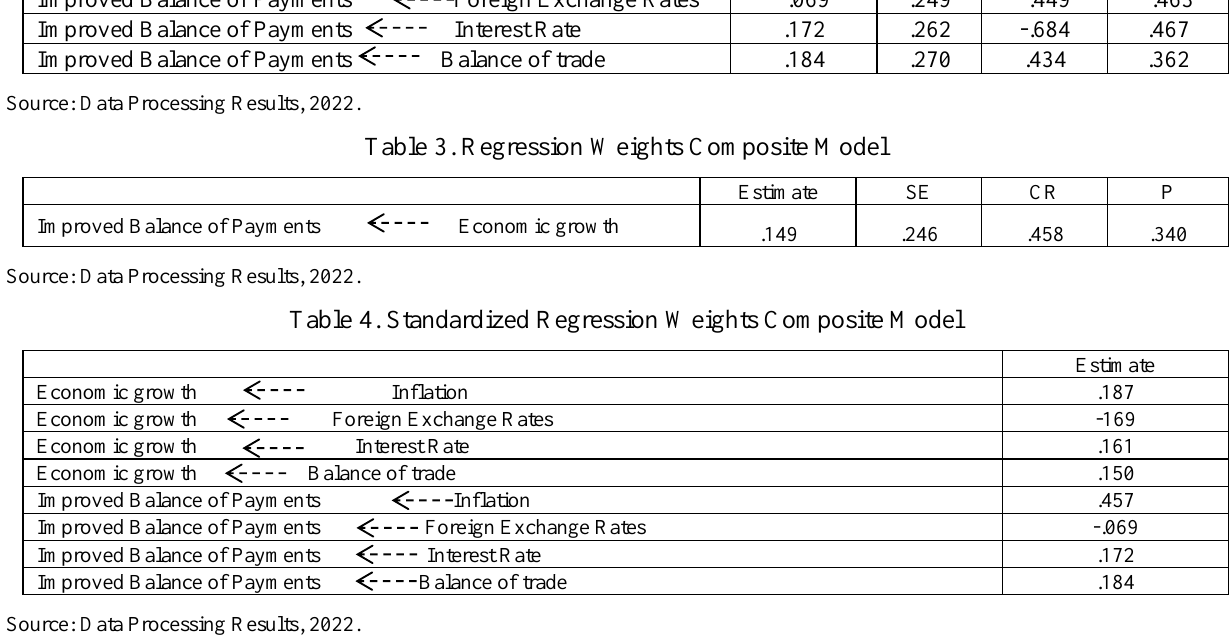
Table 5. Standardized Regression Weights Composite